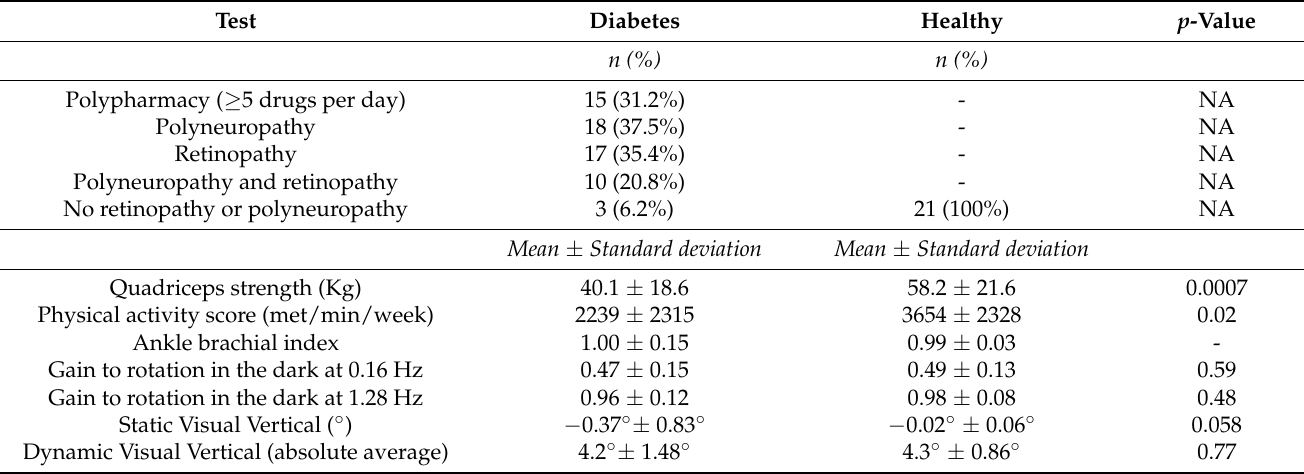
Table 2. Results on the evaluations of the participants in the study: 48 patients with diabetes and 21 healthy subjects. Comparisons were performed using “ t ”